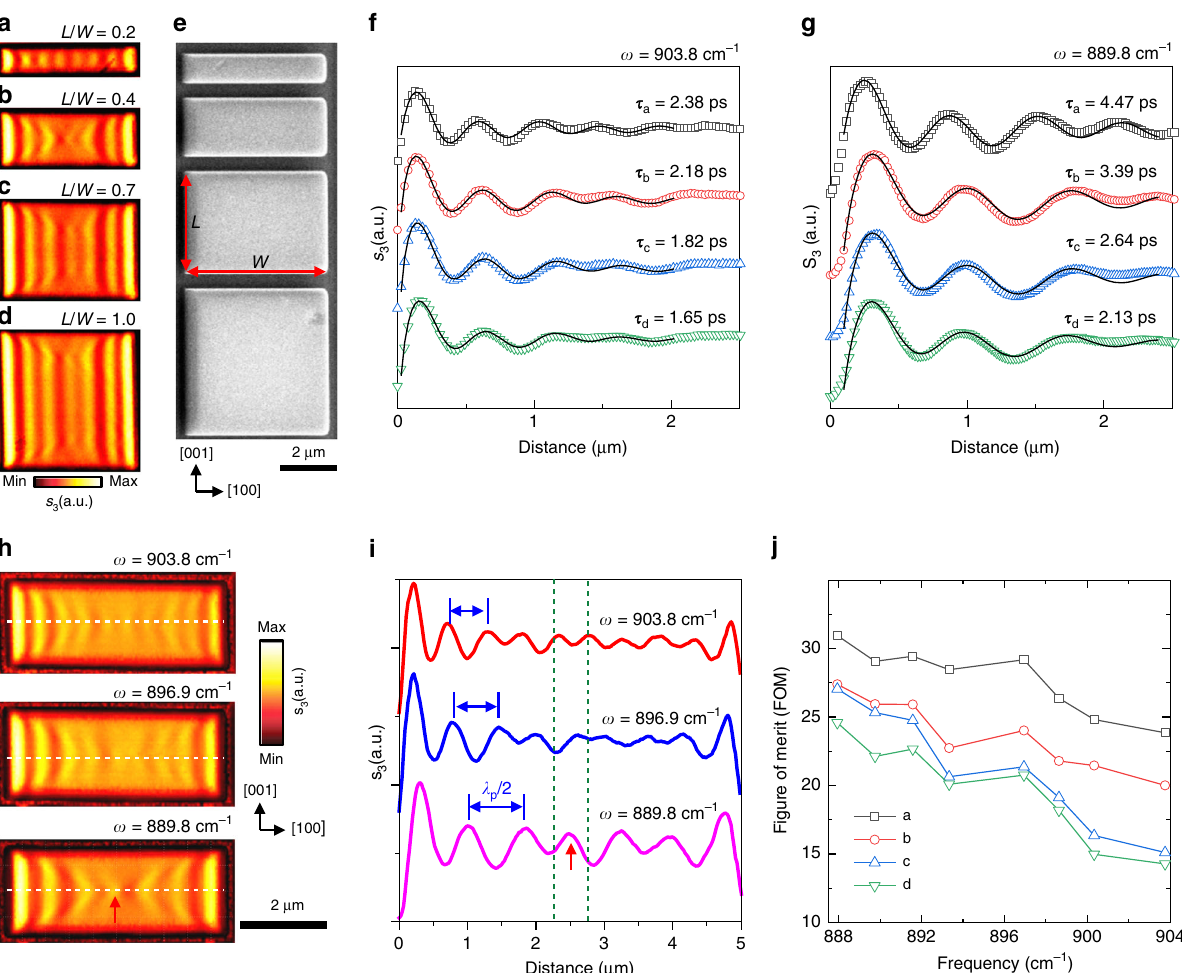
Fig. 4 Lifetimes and FOM of hyperbolic PhPs synergistically regulated by aspect ratio and frequency. a – d Near- fi eld images of large rectangular α -MoO 3 nanocavities with different aspect ratios. The length L = 1 μ m, 2 μ m, 3.5 μ m, and 5 μ m, respectively. L along the [001] direction and W along the [100] direction are de fi ned in panel e . The width W is 5 μ m and the thickness d is 175 nm. ω = 896.9 cm − 1 . e SEM image of nanocavities in panel a – d . f , g Lifetime of hyperbolic PhPs in α -MoO 3 nanocavities with different aspect ratios at ω = 903.75 cm − 1 and 889.8cm − 1 , respectively. s-SNOM line traces along the [100] direction of the nanocavities (color hollow patterns) in Fig. 4a – d, respectively. Damped sine-wave functions (black solid lines) were fi tted to the data. h Nano-infrared images of near- fi eld amplitude s ( ω ) in rectangle α -MoO 3 nanocavities at the frequencies 903.8 cm − 1 , 896.9 cm − 1 , and 889.8 cm − 1 , respectively. The length L , width W and thickness d of rectangle are 5 μ m, 2 μ m and 155 nm, respectively. i s-SNOM line traces along rectangle α -MoO 3 nanocavities shown in ( h ). i , s-SNOM line traces along rectangle α -MoO 3 nanocavities shown in ( h ). Red arrow and green dashed lines are guides for the eye of hyperbolic hot-spot in the image and corresponding s-SNOM line trace. j FOM of rectangular α -MoO 3 nanocavities in panel ( a – d ) as a function of